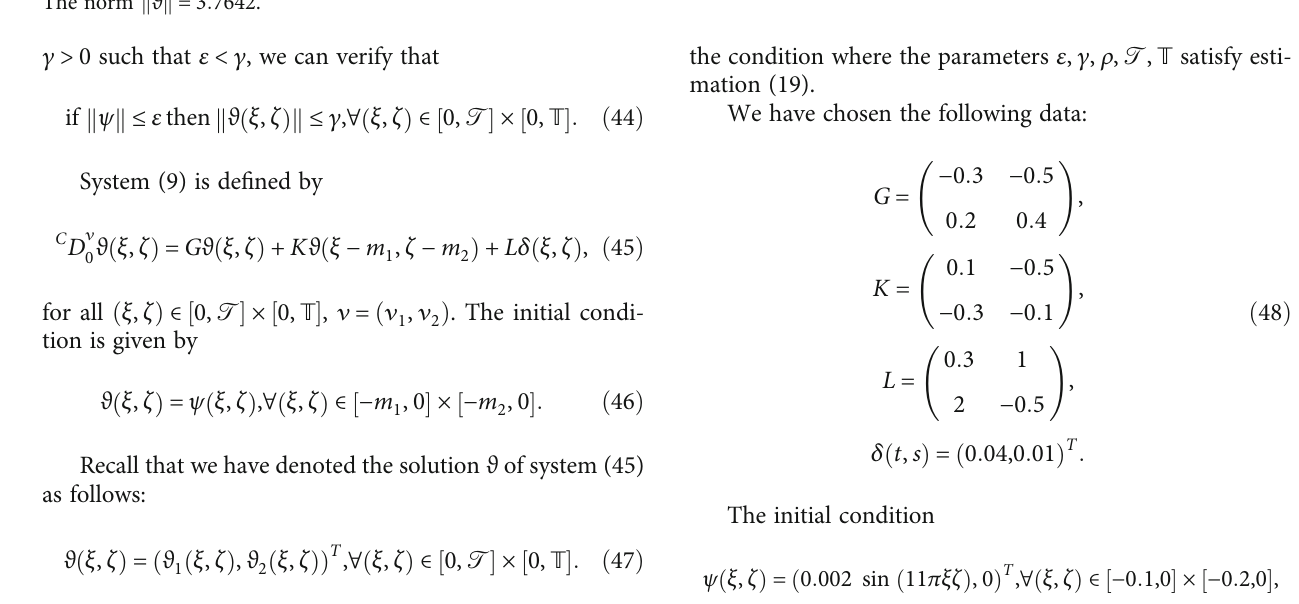
ϑ 1 and 2 are represented in (a) and (b), respectively.